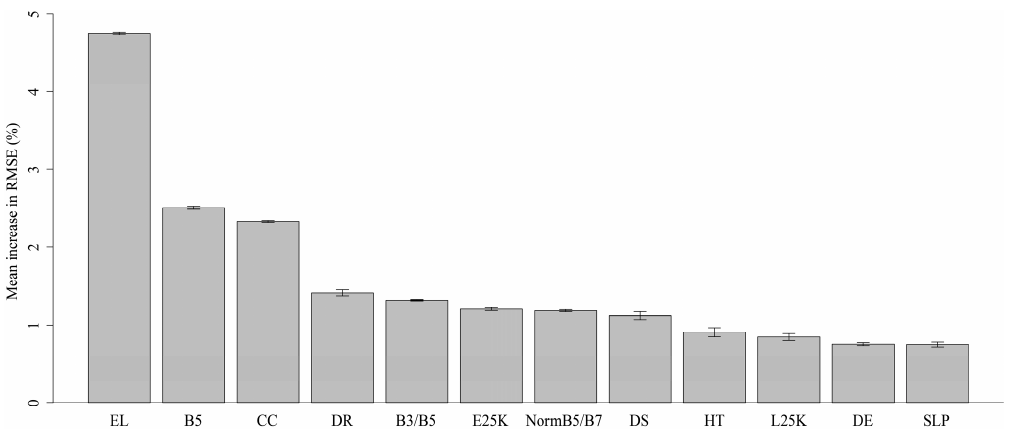
Figure 6. Relative importance of 12 variables selected for final Random Forest model after recursive feature elimination. Confidence intervals (95%) were calculated using bootstrap sampling ( N = 50). Variable importance was measured by the mean increase in RMSE % when values for a variable were randomly permuted.